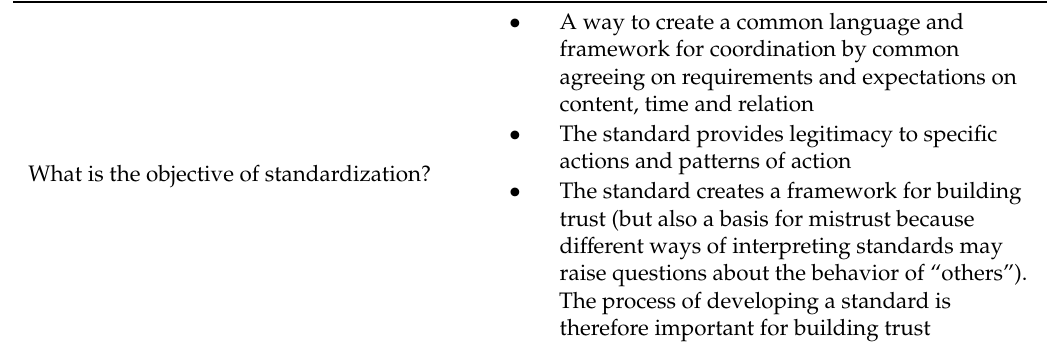
Table 5. Standardization in patient